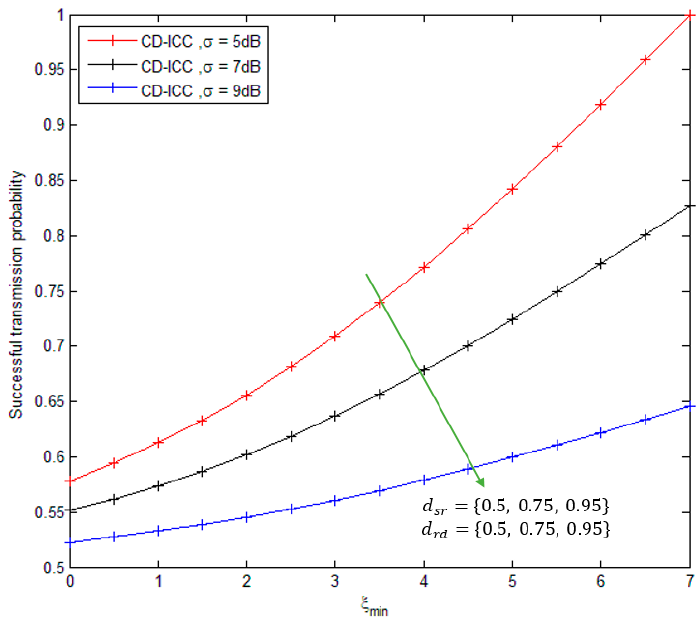
Figure 4. Successful transmission probability of CD-ICC with ξ min . In all cases, d sd is 1, and ρ is 3.5.